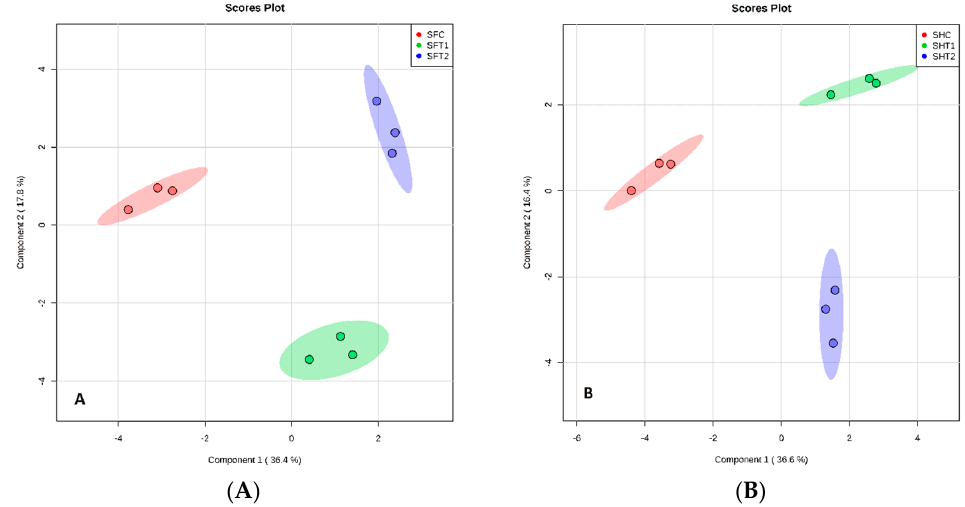
Figure 4. sPLS-DA model obtained from the classification of stems from Floribunda and Hybrid Tea roses samples based on VOCs according to BA treatments. ( A ) Score plot of Floribunda and ( B ) for the Hybrid Tea stems. Red, green and blue colors indicated groups of treatments. S represents Stems, F represents Floribunda, H represents Hybrid Tea. While C represents control, T1 and T2 represent 100 and 200 mg/L BA, respectively. Three dots in each group mean n = 3 biological